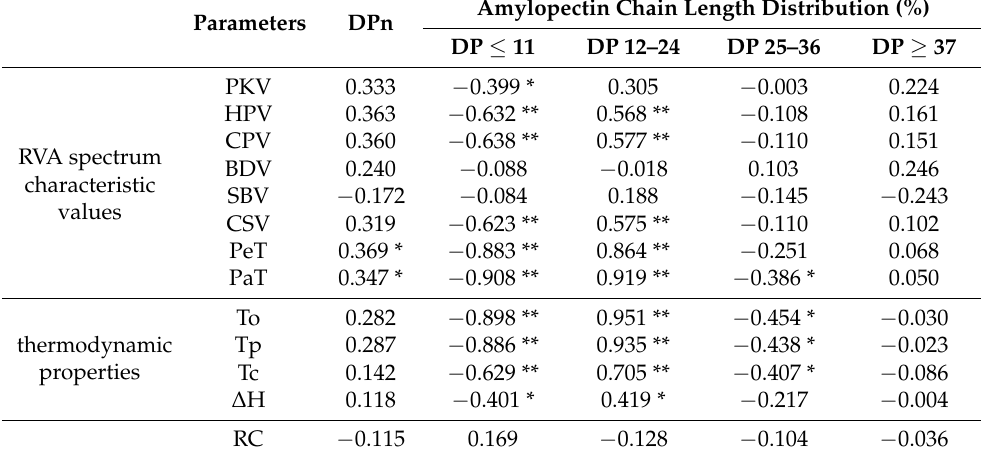
Table 6. Correlation analysis between the amylopectin structure and physicochemical properties of